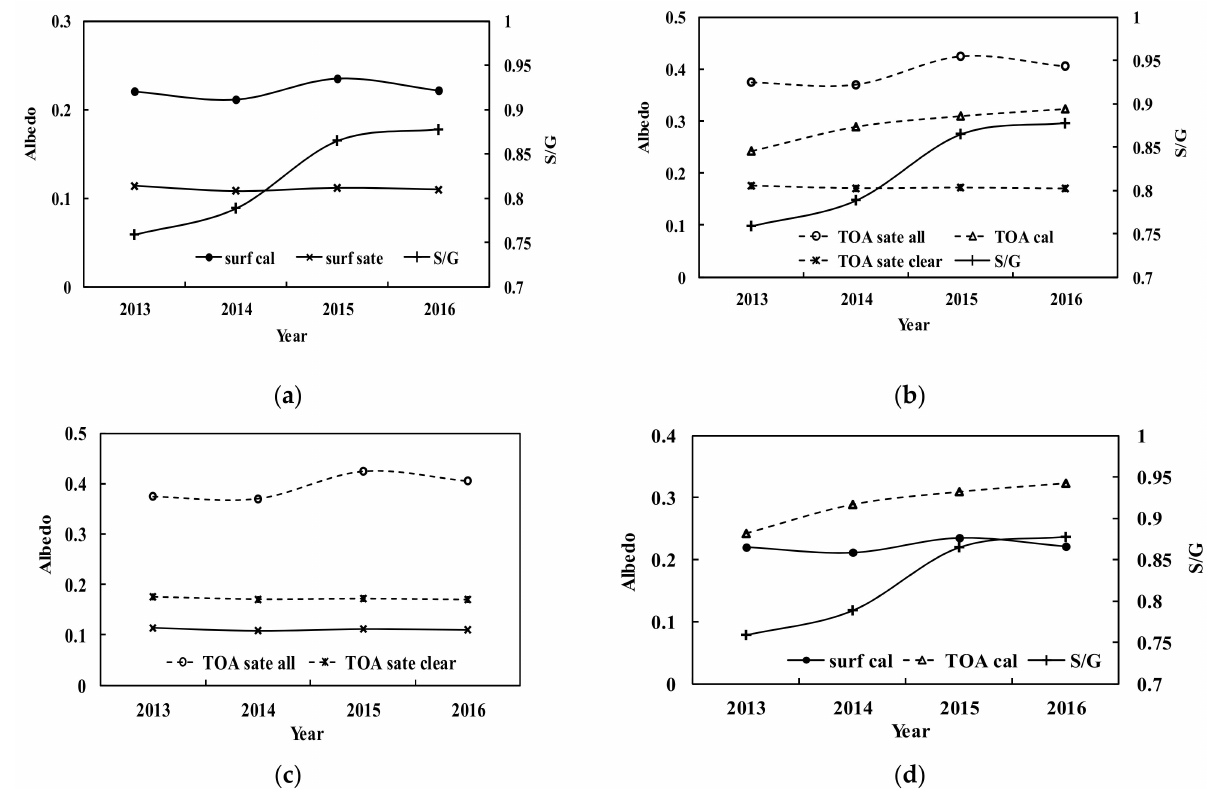
Figure 11. Annual mean albedos retrieved from satellite data (CERES, denotes as sate) under all and clear sky conditions (all, clear) and albedo calculated using Equations (7)–(9) at the surface and at the TOA (surf, TOA), and annual